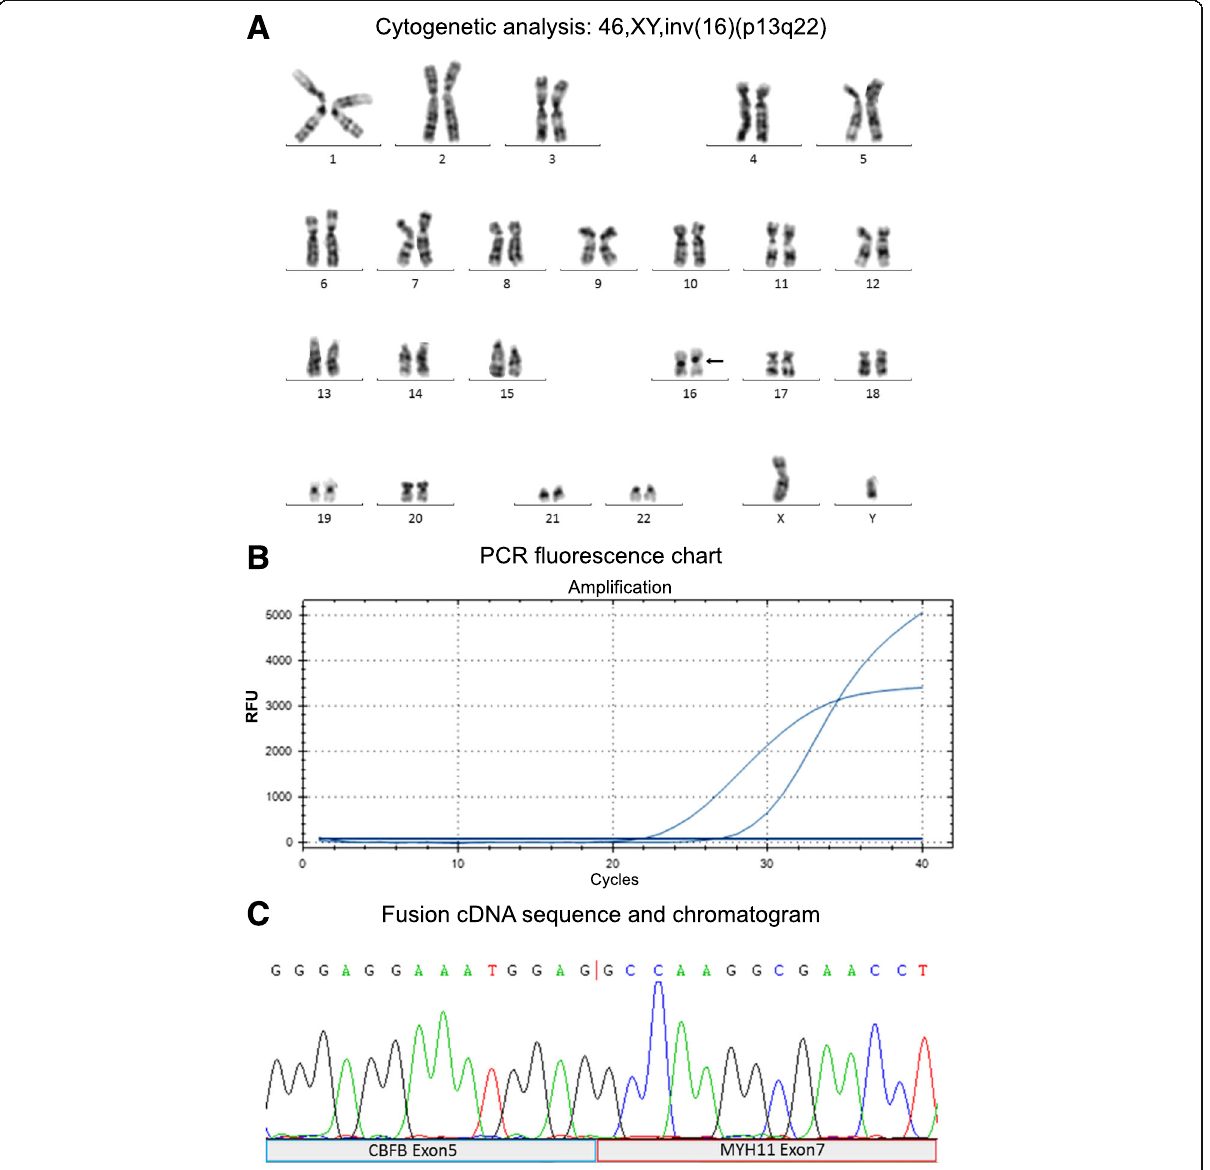
Fig. 1 Molecular and cytogenetic screening in hematological malignancies. a Cytogenetic analysis of bone marrow biopsy identified with a karyotypic chromosomal rearrangement inv(16)(p13;q22) ( black arrow ). b PCR fluorescent chart showing amplification curve for both targeted gene fusion and housekeeping reference cDNA products. c DNA sequence ( top ) and chromatograph ( bottom ) of a CBF β -MYH11 fusion transcript (cDNA). Chromosomal breakpoint is indicated by a red line within the DNA sequence. Contributing exons from each gene (DBFB exon 5 and MYH11 exon 7) are indicated below ( blue and red shaded labeled regions